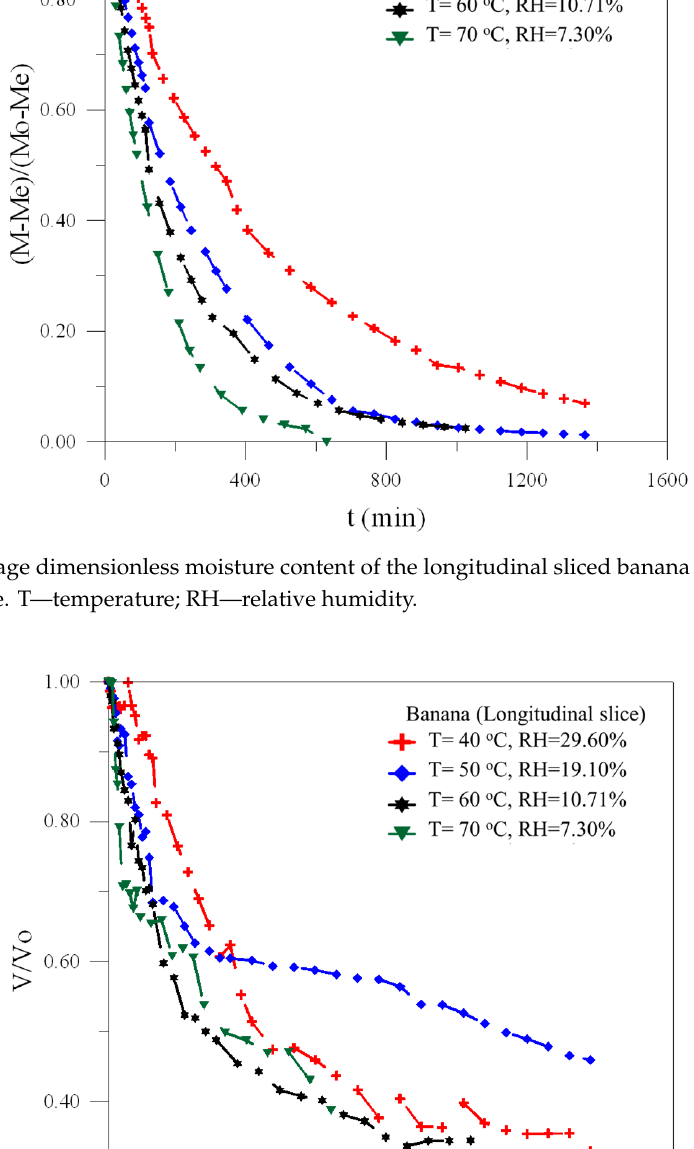
Figure 4. Dimensionless volume of the longitudinal cut banana as a function of moisture content. It is noted that, for all drying temperatures, at the beginning of the process, there is a higher drying rate. Thus, the dimensions of the fruit changes from a high shrinkage speed until it tends to zero. However, comparing the drying behavior, it is observed that, for the drying temperatures, of 40 °C and 50 °C, the variation in the volume of the banana occurs more uniformly, due to the fact that the water removal is slower, promoting drying and longer heating. For high temperatures, for example, 60 °C and 70 °C, at the beginning of the process, there is a great loss of water from the banana, thus causing a sudden reduction in its volume. There is also a linear trend in volume with moisture content, indicating that the reduction in the volume of bananas equals the amount of water removed with the progress of the drying, except for a longer time (>300 min), where combined effects of expansion due to heating and contraction due to moisture removal are more important. This effect can be verified by the changes in the behavior of the curves for longer time, which drop smoothly